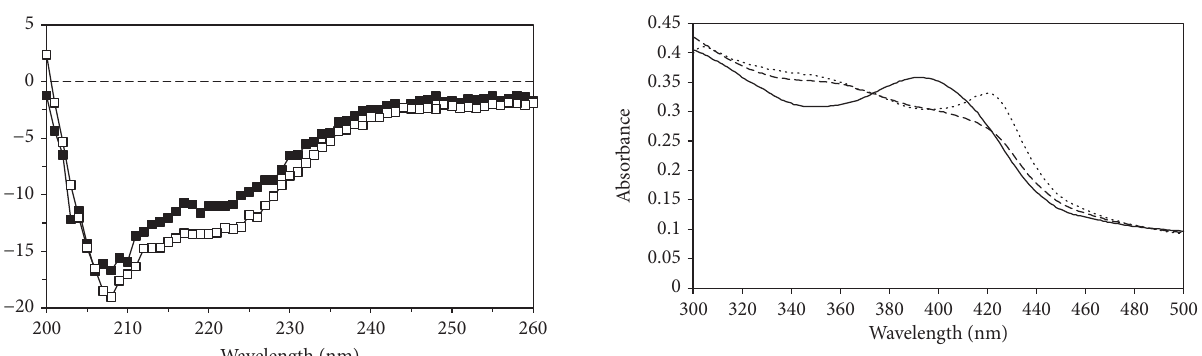
Figure 4: CD spectra of sol-gel entrapped CPO (black squares) and free CPO (white squares). The CPO concentration was 7 𝜇 M in the silica sol-gel sheet of ∼ 1mm thickness. The solution sample containing 7 𝜇 M CPO in 2 mM sodium phosphate buffer, pH 7.0, was measured in a cuvette of 1mm path length.